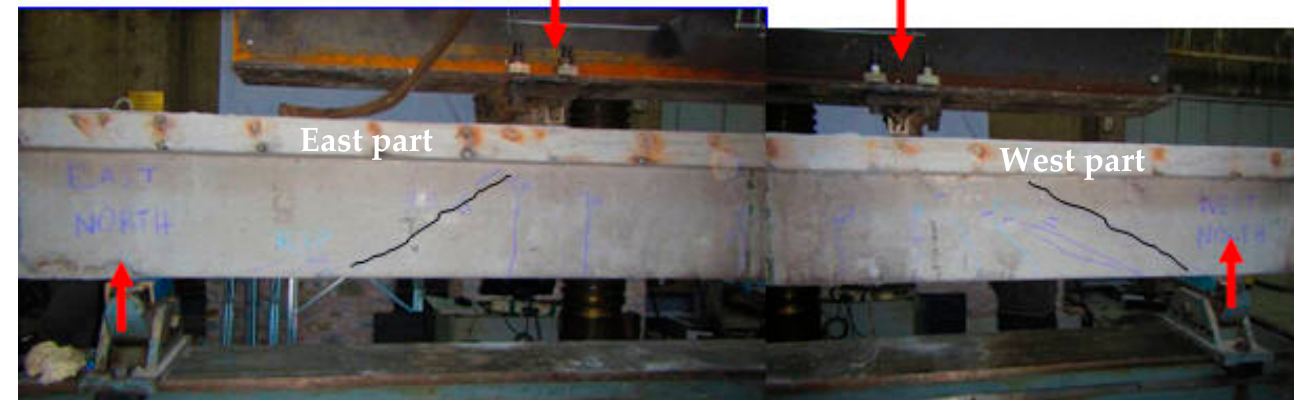
Figure 15. Virgin prototype RC T-beam that reached a shear limit state under four-point bending.